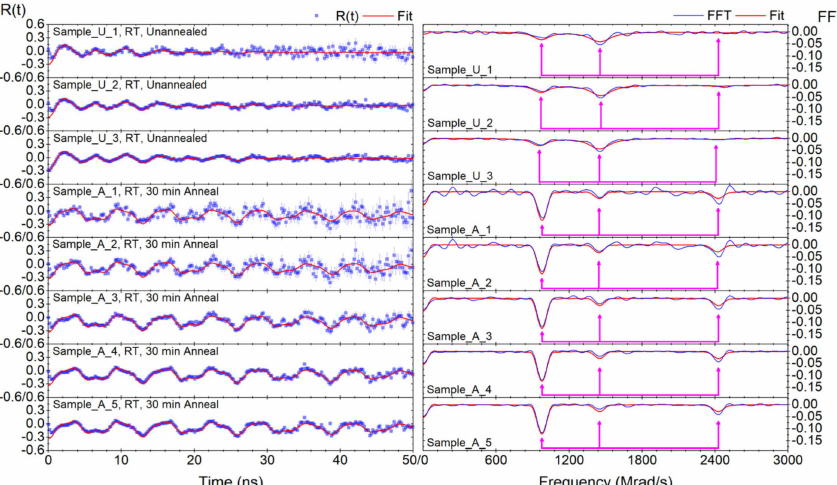
Figure A1. ( left ) R(t) graph and ( right ) corresponding FFT spectrum of 2 sets totaling 8 different e − γ TDPAC measurements of 181 Ta(TiO 2 ). The additive constant for set “U_” (Unannealed) varies for all 3 members. The additive constant for set “A_” (30 min annealing at 873K) is − 0.0398. The TDPAC probe used is 181 Hf → 181 Ta, with the raw TDPAC spectrum (from the coincidence searches on the detectors) processed and converted into R(t) observables [see blue curves in the R(t) and their corresponding FFT graphs] by Interlude TM [see Equations (2)–(5)]. The R(t) signals are then fit by using the Gfit19 TM program [see red curves in R(t) and the corresponding FFT graphs]. For clarity, we show only the first 50 ns on the R(t) graph because shorter coincidence searches of e − γ rays are less noisy and thus more statistically significant than longer coincidence searches.